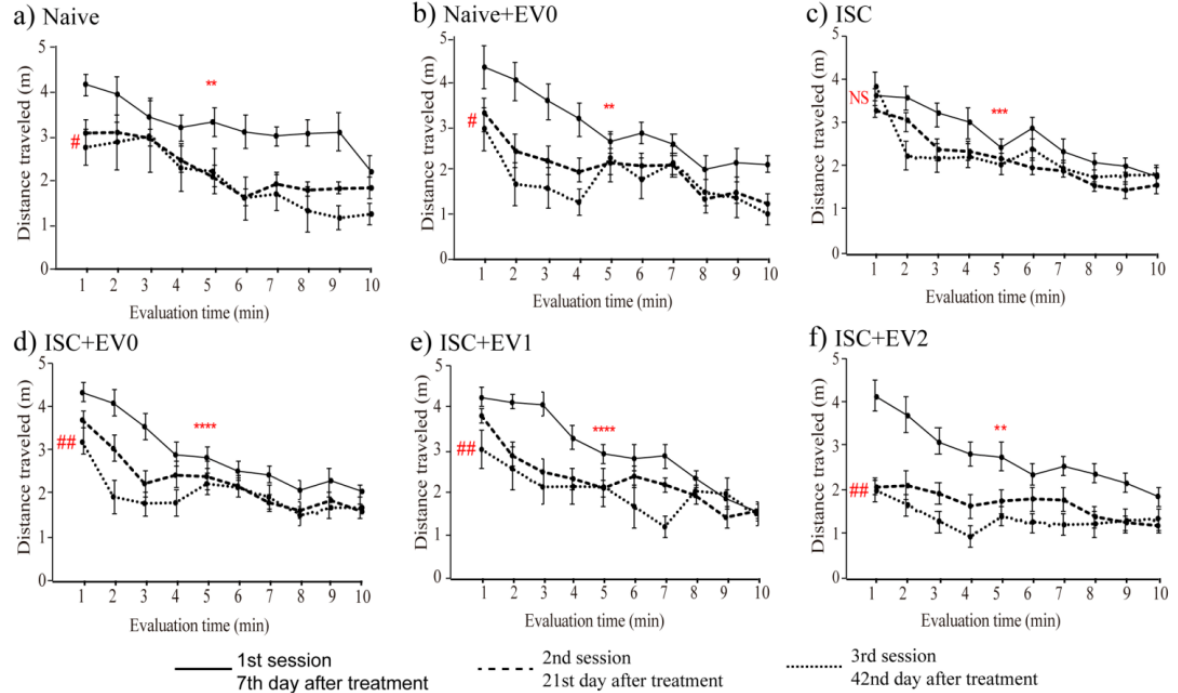
Figure 6. Open field task. Sessions were performed on days 7, 21, and 42 after treatment. Groups: ( a ) naive (n = 8), ( b ) naive + EV0 (n = 6), ( c ) ISC (n = 16), ( d ) ISC + EV0 (n = 16), ( e ) ISC + EV1 (n = 15), and ( f ) ISC + EV2 (n = 16). Statistical analysis using 2-way ANOVA, followed by the Tukey’s multiple comparisons test. Data are reported as mean ± SEM. ** p < 0.01, *** p < 0.001, **** p < 0.0001 comparing the 1st min with the 5th min only in the first session; # p < 0.05, ## p < 0.01, comparing the 1st min of the first session with the 1st min of the second/third or third sessions. NS = not statistically signifi- cant.